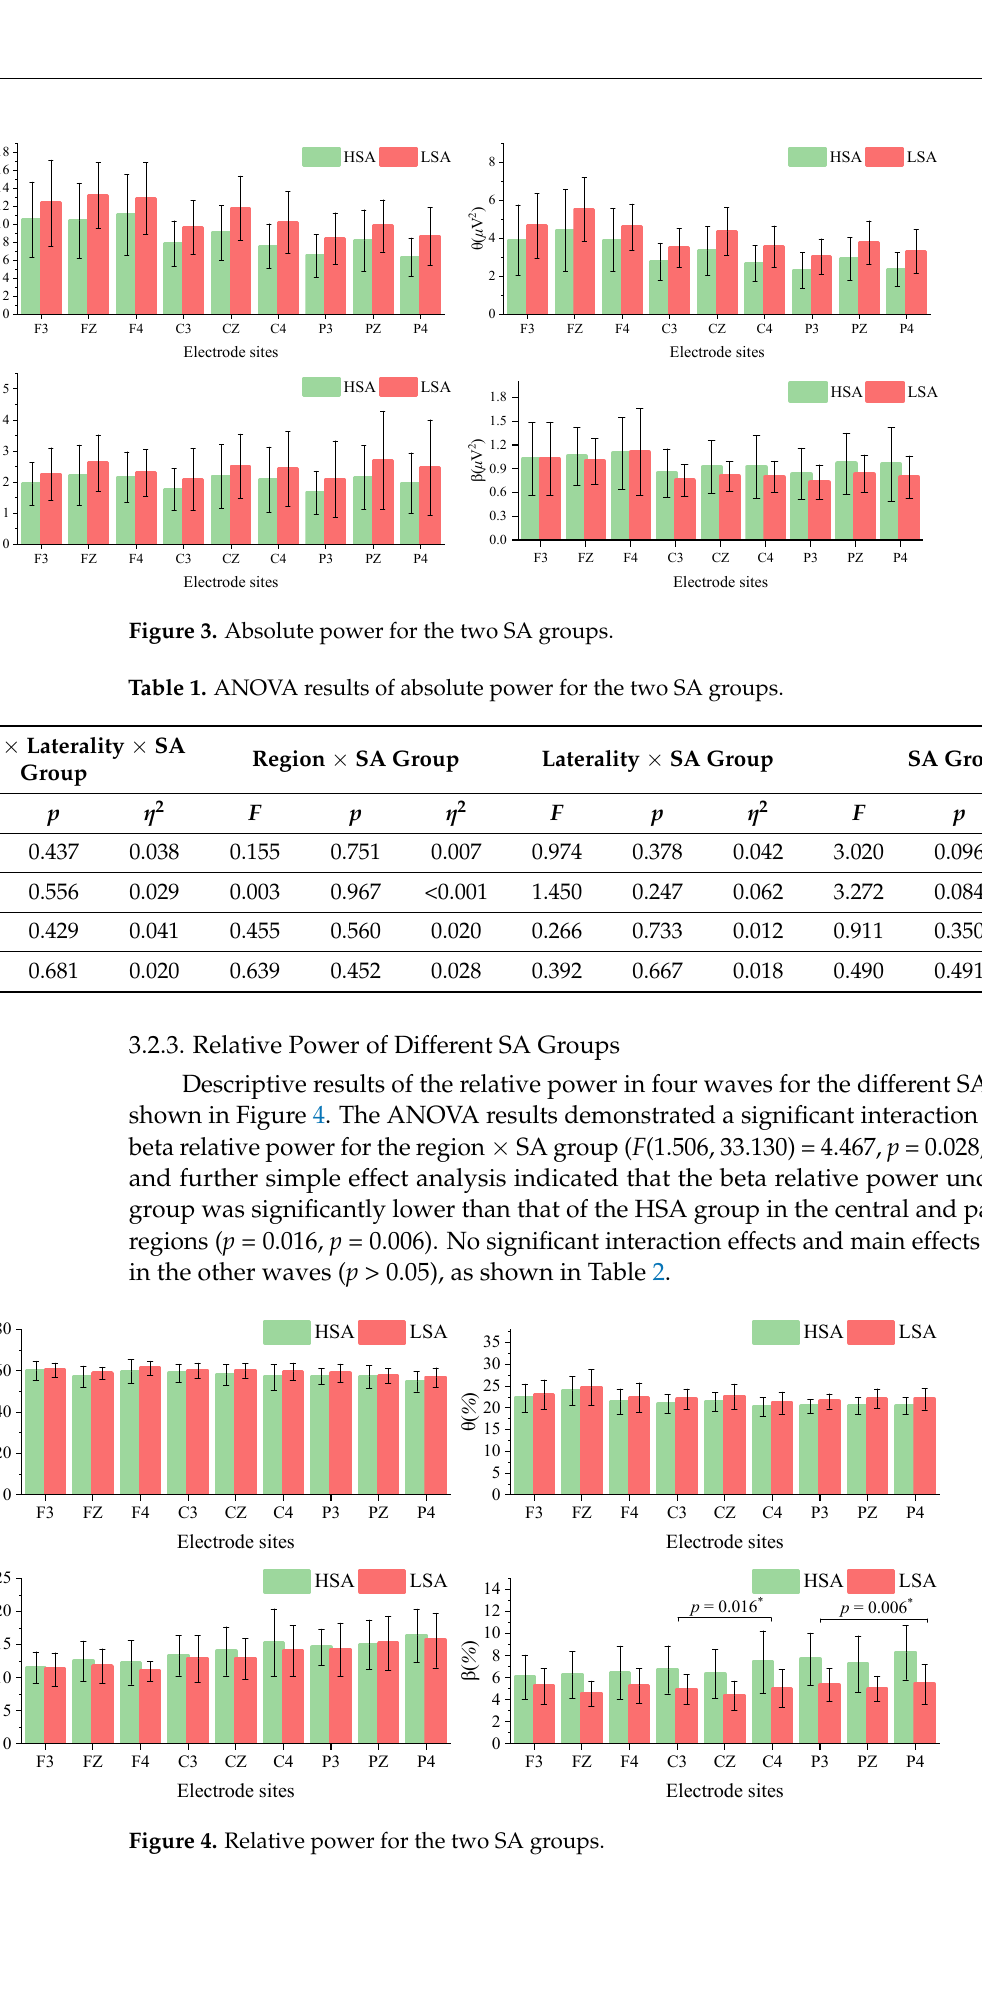
Regions analysis Figure 2. Three types of EEG features and channel locations for the two SA groups.